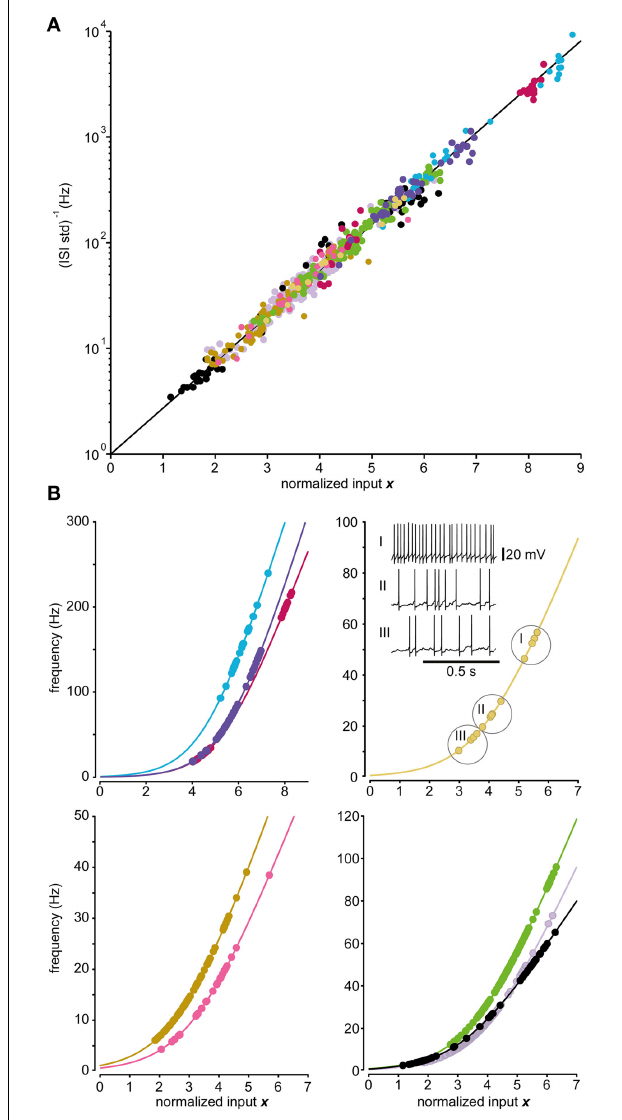
FIGURE 5 | Predictions of firing frequencies for spinal interneurons. (A) Relationship between the normalized input and the logarithmic value of the inverse of the standard deviation of the ISI distribution for the model (line) and the recorded data of the 9 spinal interneurons tested. Each spinal interneuron is represented by a set of dots indicated by the same color. The recorded states are expected to lie upon the line according to Equation (6a). (B) Relationship between the normalized input and the firing frequency in the model (line) and the recorded data for the 9 spinal interneurons (dots) divided into 4 separate panels. The neurons are shown in different panels as they occupy different ranges of firing frequencies. Note differences in curvature and steepness of the curves between individual neurons. The inset displays three sample firing levels for one recorded neuron, as indicated by the encircled values in the